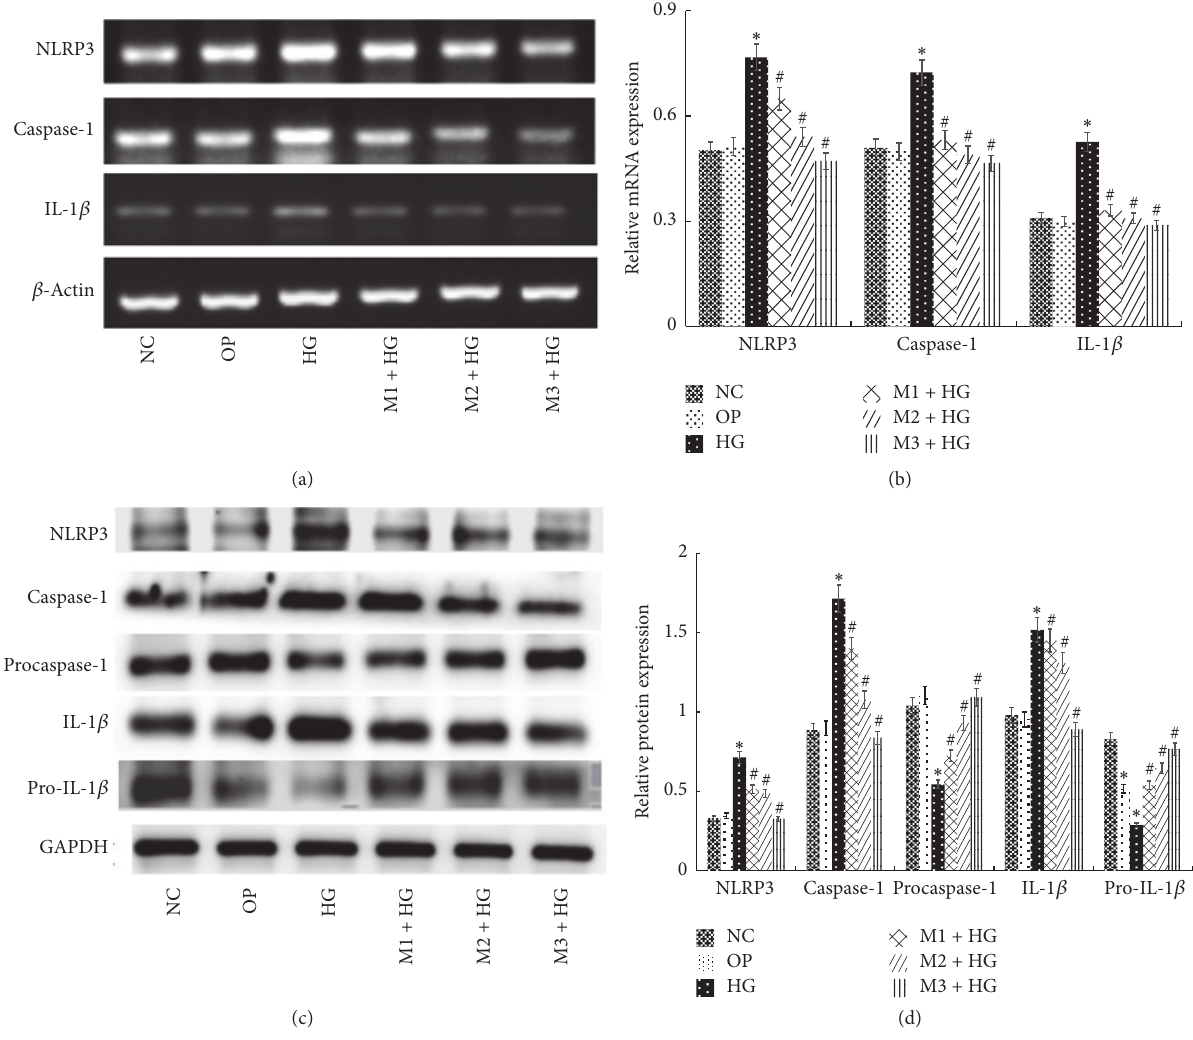
Figure 2: The mRNA and protein level of NLRP3, caspase-1, procaspase-1, IL-1 𝛽 , and pro-IL-1 𝛽 in each group. (a) RT-PCR detected the expression of NLRP3, caspase-1, and IL-1 𝛽 mRNA after intervened by high glucose and maresin 1 for 24 h in GMCs, and the mRNA expression of NLRP3, caspase-1, and IL-1 𝛽 increased in HG group significantly, but compared with HG group, it decreased obviously in M + HG group as a concentration-dependent manner of maresin 1. (b) The corresponding relative gray value statistics graph of the mRNA level. ∗ 𝑃 < 0.05 versus NC group, # 𝑃 < 0.05 versus HG group. (c) Western-blot detected the expression NLRP3, caspase-1, procaspase-1, IL-1 𝛽 , and pro- IL-1 𝛽 protein after intervened by high glucose and maresin 1 for 24 h in GMCs, and the protein expression of NLRP3, caspase-1, and IL-1 𝛽 increased and procaspase-1 and pro-IL-1 𝛽 decreased in HG group significantly, but compared with HG group, the protein expression of NLRP3, caspase-1, and IL-1 𝛽 decreased and procaspase-1 and pro-IL-1 𝛽 increased obviously in M + HG group as a concentration-dependent manner of maresin 1. (d) The corresponding relative gray value statistics graph of the protein level. ∗ 𝑃 < 0.05 versus NC group, # 𝑃 < 0.05 versus HG